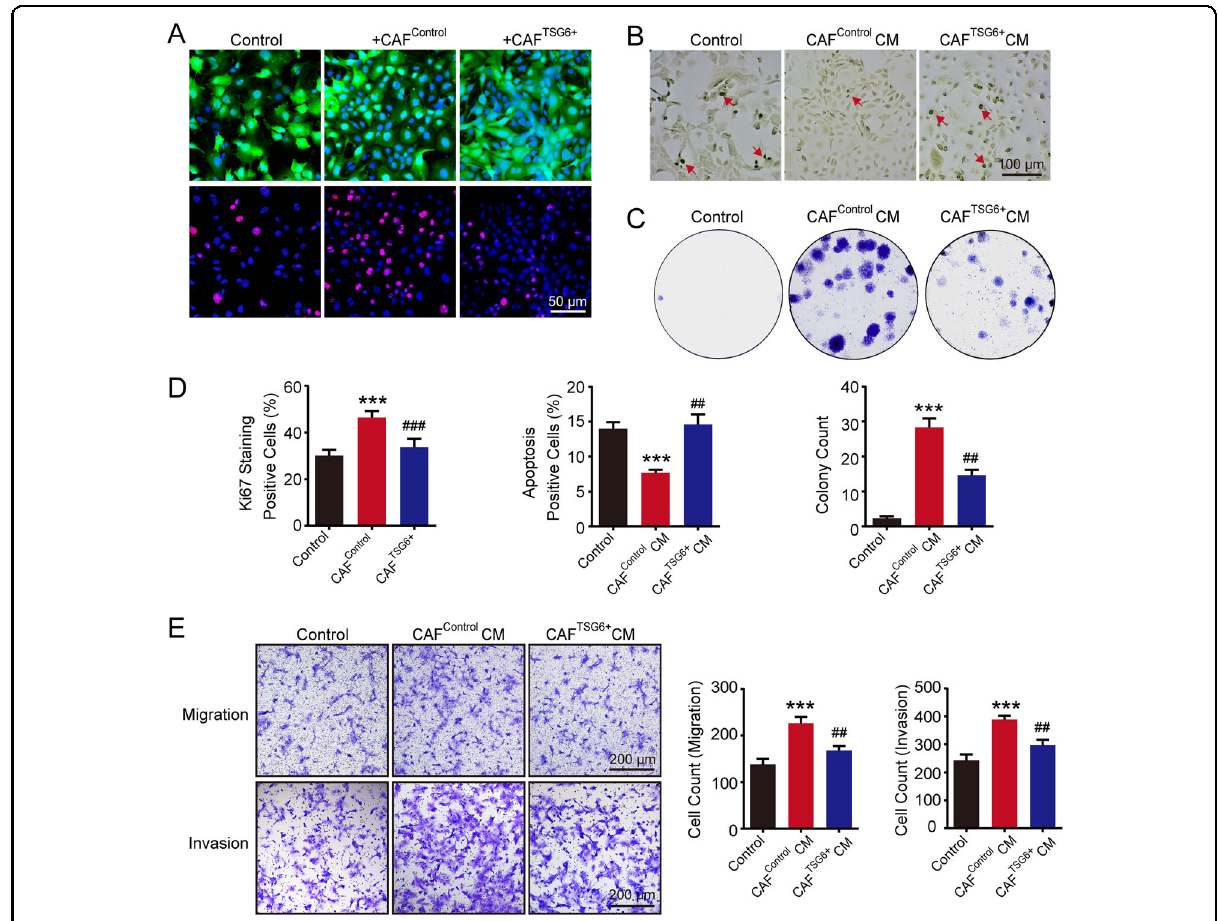
Fig. 4 The ability of CAF in promoting breast cancer malignancy was inhibited when HA cross-linking was reacquired. A MMTV tumor cells stained with cell tracker (green) were co-cultured with or without corresponding cancer-associated fi broblasts (CAF Control and CAF TSG6 + ) in TSA. After 72 h, the proliferation of tumor cells was determined by staining Ki67. B After stimulation with conditioned media (CM) of CAF Control or CAF TSG6 + , the apoptosis (red arrows) of tumor cells was evaluated. C The colony formation abilities of tumor cells treated with CAF Control CM or CAF TSG6 + CM. D The statistical histograms of Ki67 percentage, apoptotic percentage, and colony count of tumor cells in different groups. E The migration and invasion abilities of tumor cells. All experiments were repeated three times with similar results. Error bars represent mean ± SD values. Statistical analysis was performed using Student ’ s t test. *** p < 0.001 (vs Control), ## p < 0.01, ### p < 0.001 (vs CAF Control or CAF Control